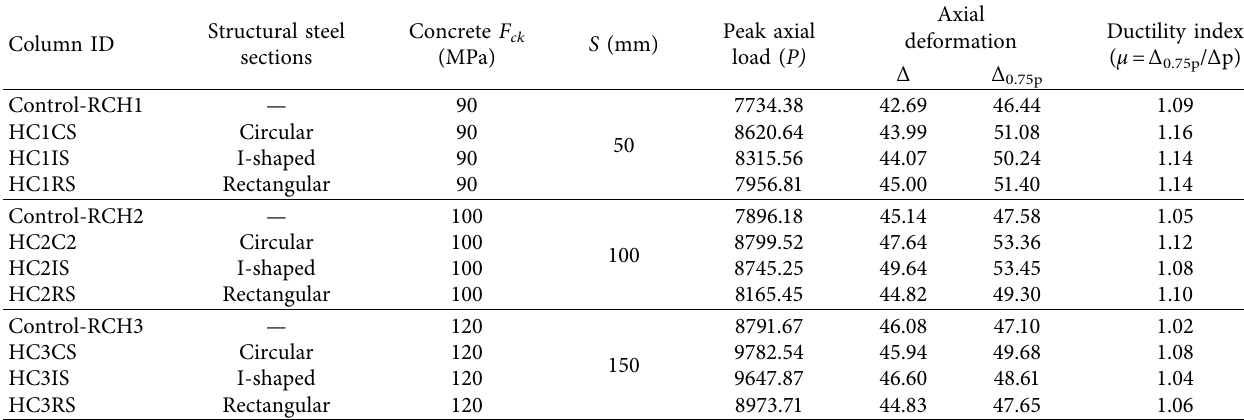
Table 13: Ductility index of columns due to structural steel